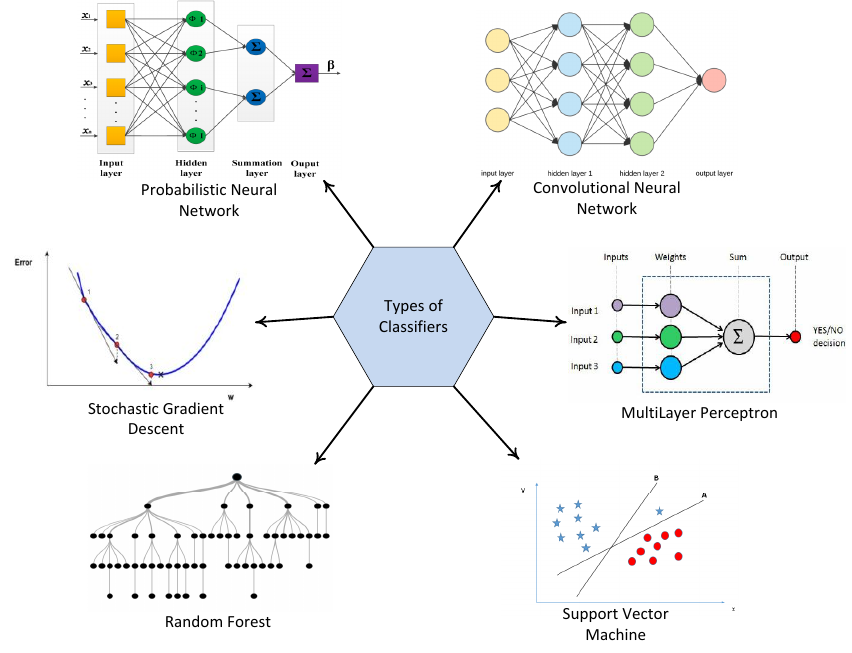
Figure 1. Types of